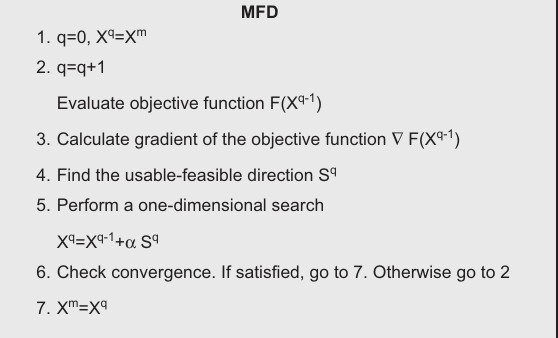
Figure 2 Flow chart of modifi ed feasible direction method.